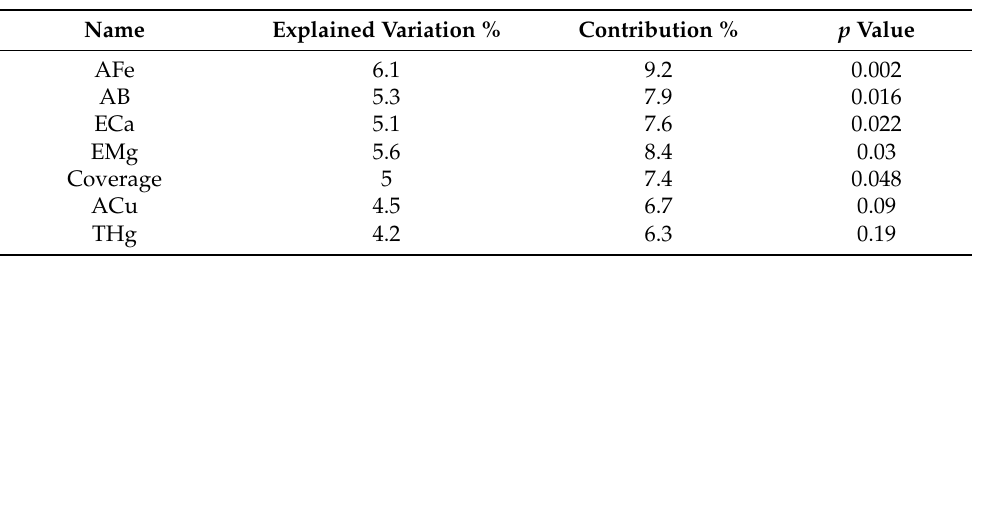
Table 7. Effects of environmental variables on species